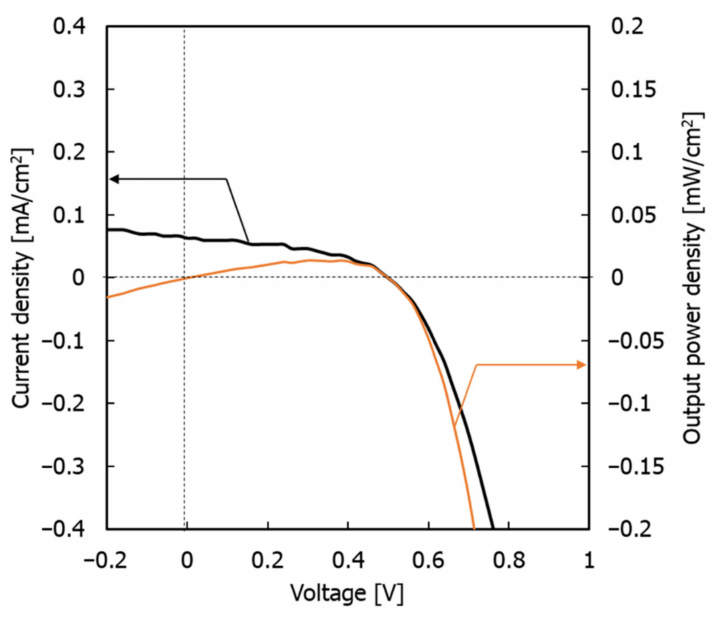
Figure 8. J–V characteristics for solar cell under the LED indoor light at 1000 lx. The maximum power density (P max ), J sc , FF, and PCE were 14.07 µ W cm − 2 , 0.063 mA cm − 2 , 0.5 V, 44.46%, and 4.02%, respectively. These results demonstrate that the system has the potential to be used as an indoor light-based power generation system